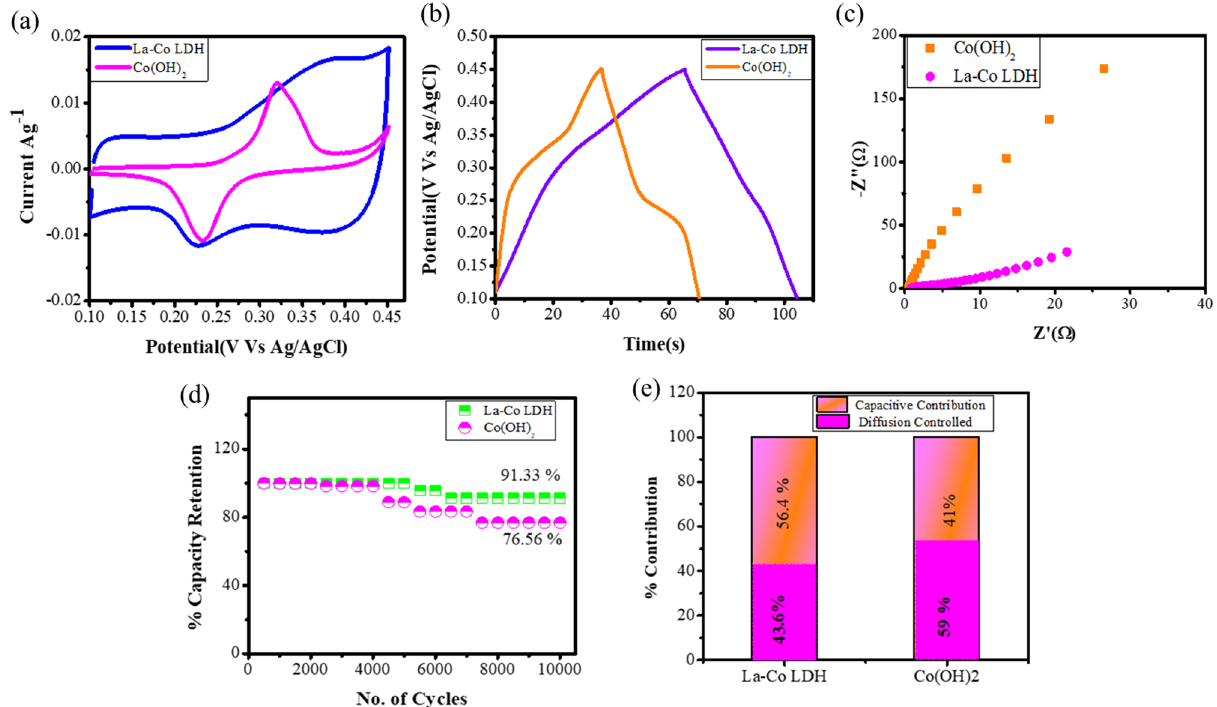
Figure 2. ( a ) Comparative CV curve of La–Co LDH with Co(OH) 2 at 10 mVs −1 scan rate, ( b ) Comparative charge discharge characteristics of La–Co LDH with Co(OH) 2 at 5 A g −1 current density, ( c ) Comparative Nyquist plot of La–Co LDH and Co(OH) 2 , ( d ) cyclic stability characteristics of La–Co LDH and Co(OH) 2 in alkaline electrolyte (2 M KOH electrolyte), ( e ) differentiation of capacitive and diffusion controlled contribution from CV curve at 10 mVs −1 scan